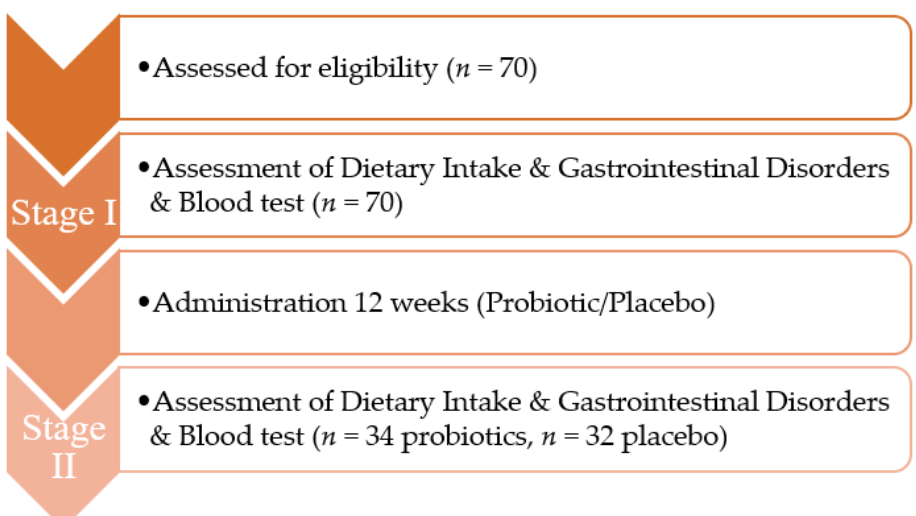
Figure 1. Seventy individuals met the study inclusion criteria. Stage I of the study included assess- ment of dietary intake, GI symptoms and blood tests. For 3 months following Stage I, participants took either a probiotic ( n = 35) or a placebo ( n = 35). After this time, Stage II of the study was conducted in which tests analogous to those in Stage I were performed in 34 people from the probiotic group and 32 people from the placebo group.